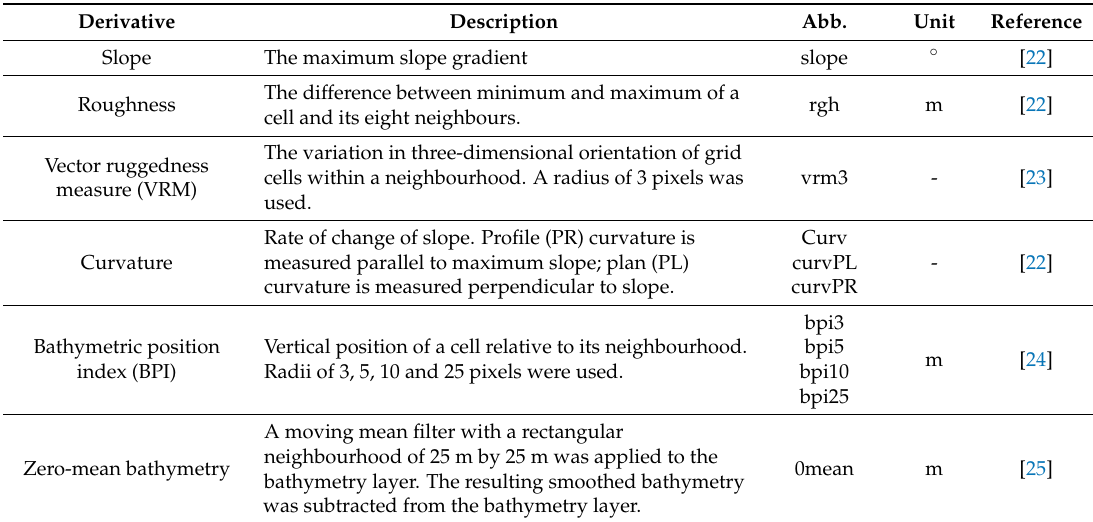
Table 1. Bathymetric derivatives utilised in this